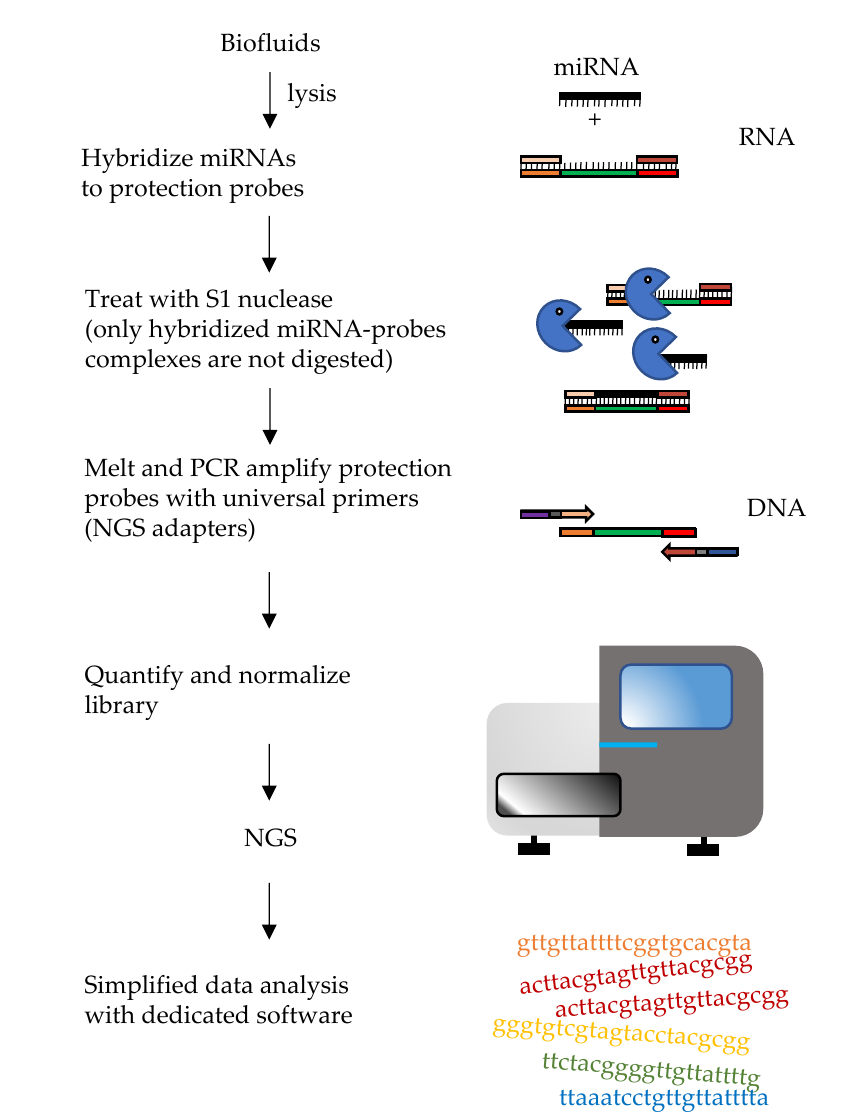
Figure 8. Diagram of HTG Edgeseq workflow. The hybridization, S1 nuclease treatment and PCR steps are depicted. These steps allow it to protect probes bound to target miRNAs, removing other RNAs and unbound probes. Wash steps are not